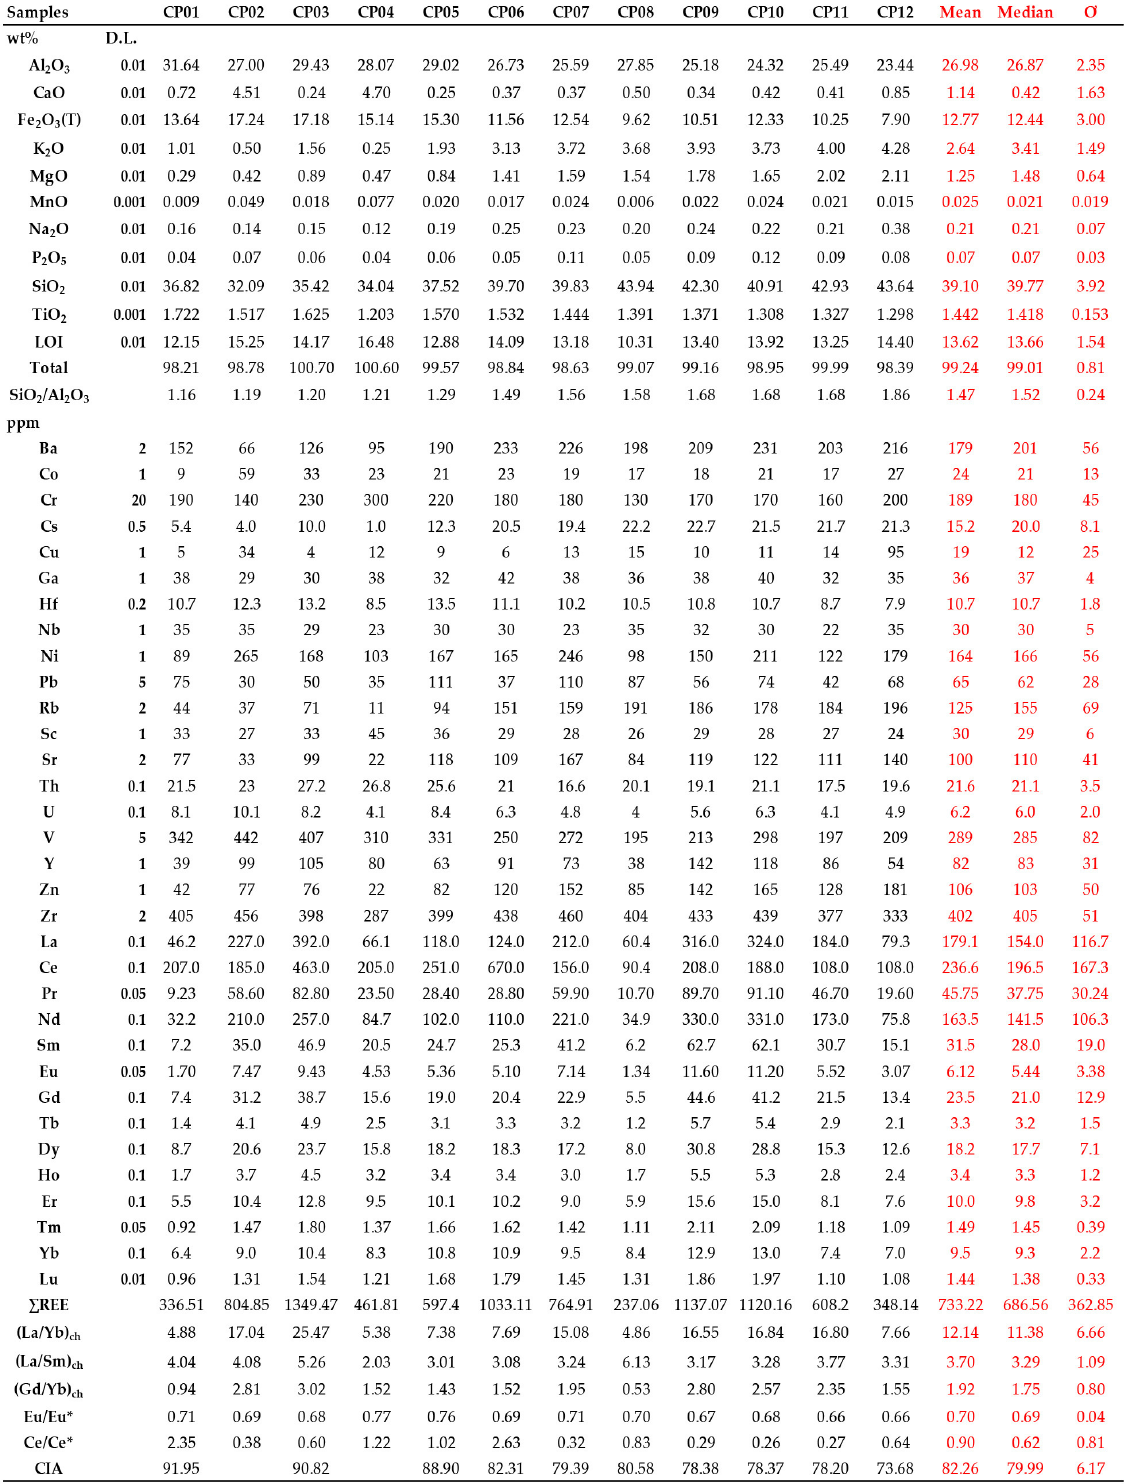
TABLE 1 | Chemical compositions of the analyzed